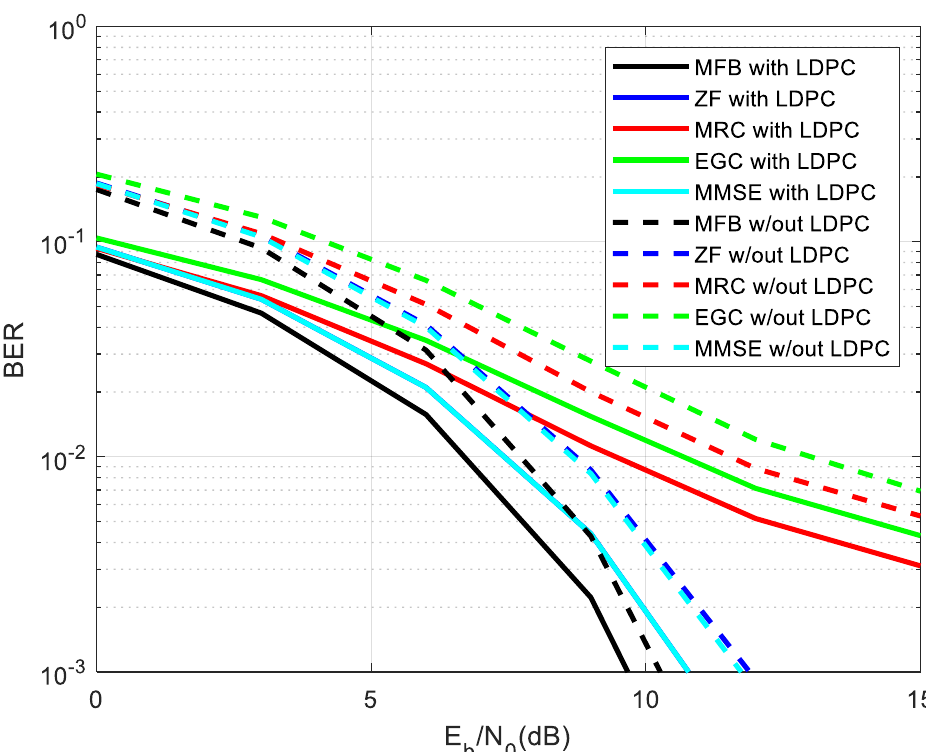
Figure 8. Results for 4X25 LIS System, with 5 users, with and without LDPC codes.